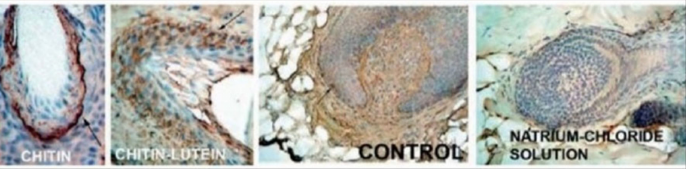
Figure 2. The CD34 radicular–follicular cells of rat-skin treated topically by CN and CN–lutein (by the courtesy of Biagini et al.